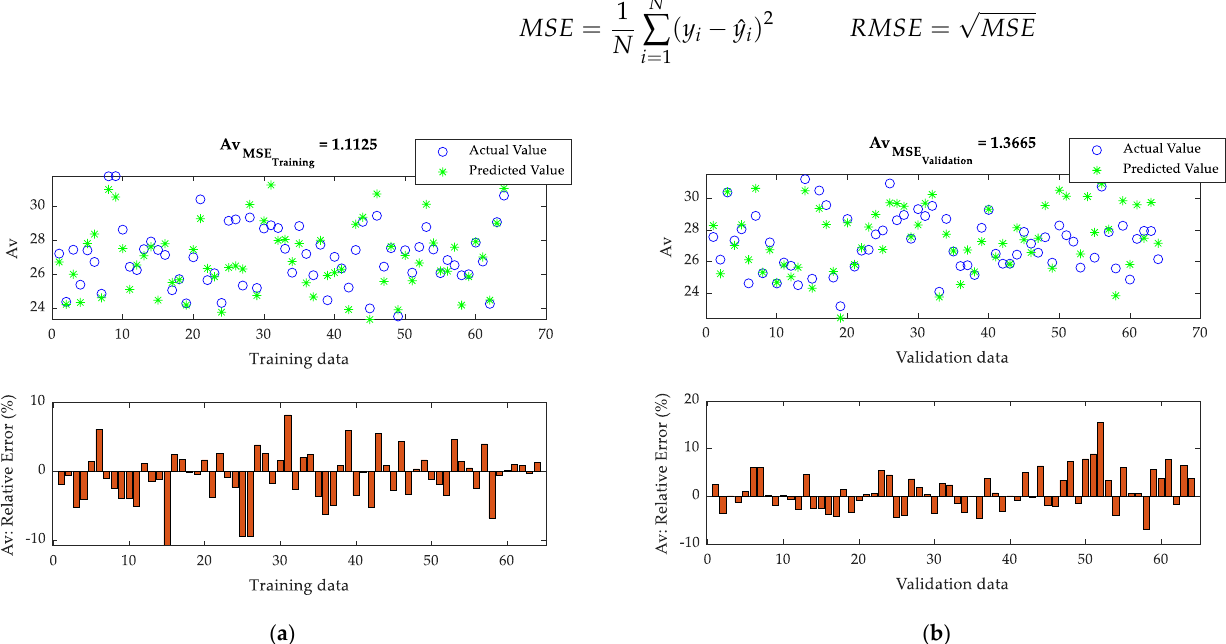
Figure 11. Results with the tuned FIS in the first step for Av: ( a ) training data; ( b ) validation data.